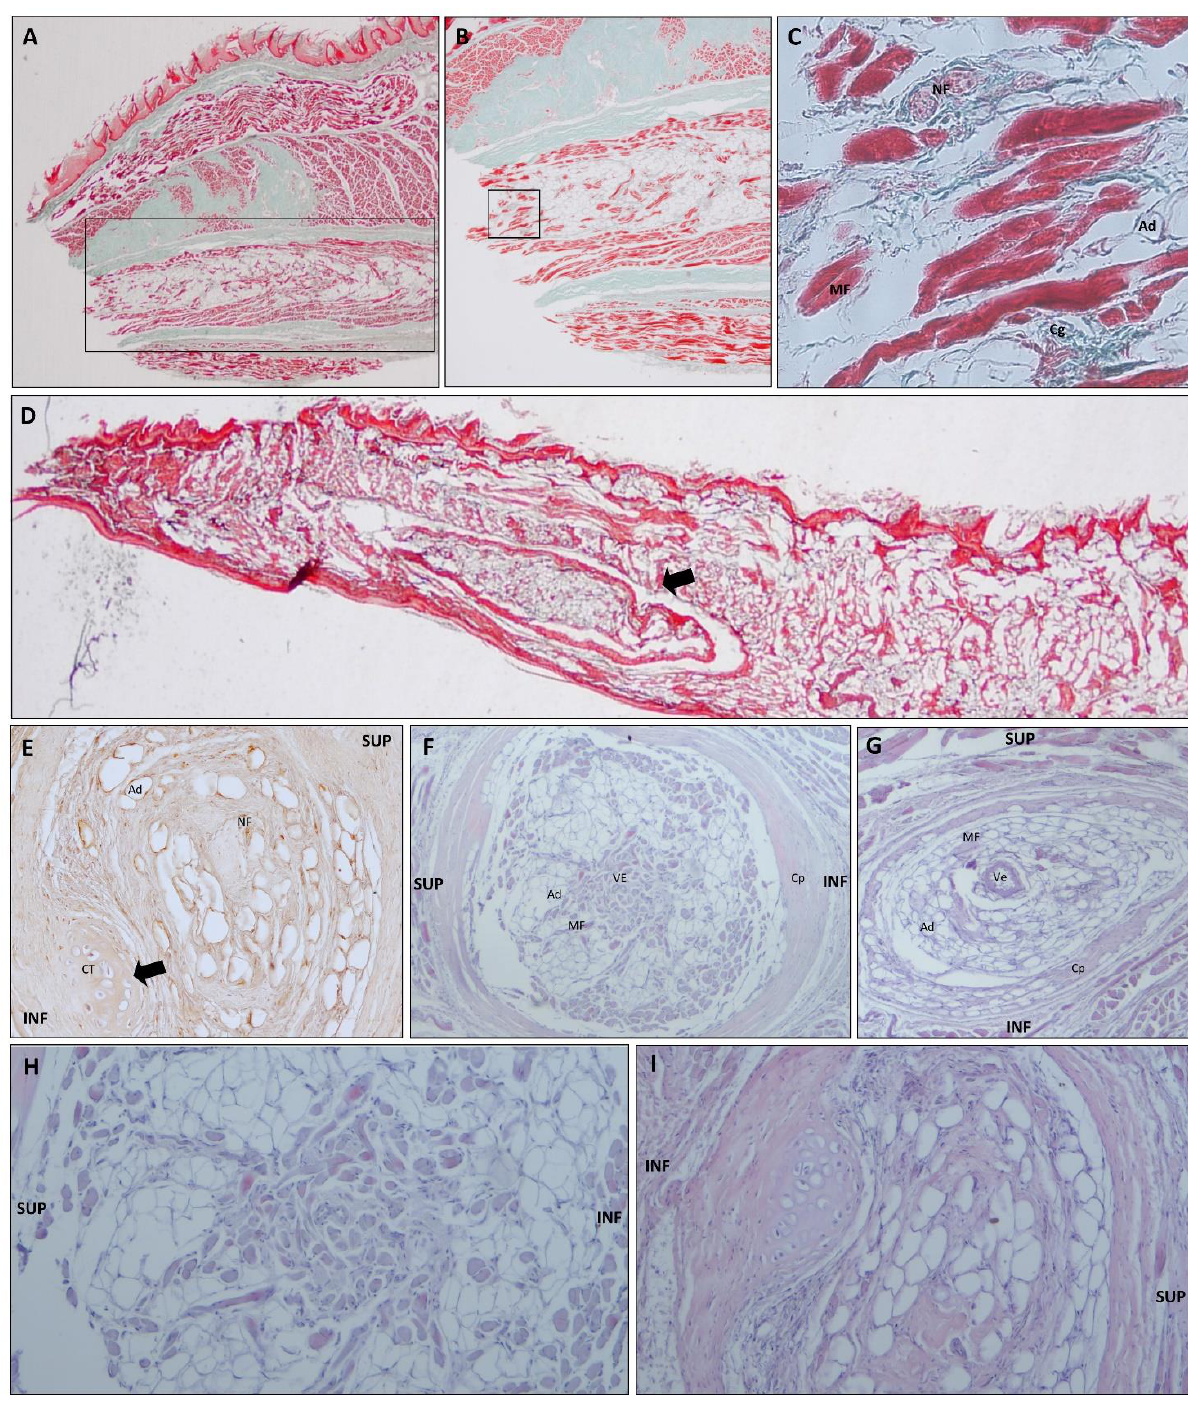
Figure 5. Images that illustrate the encapsulated structure present in the antero-ventral part of the tongue. Images ( A – C , E , I ) correspond to Lemur catta . Images ( D , F , H ) correspond to Varecia variegata . Image ( G ) correspond to Eulemur macaco . Images ( A – D ) (Masson trichrome stain) are from sagital-oriented longitudinal sections. Images ( E ) (S100 immunostain) and ( F – I ) (hematoxylin—eosin stain) are from frontal-oriented transversal sections. Some images, for descriptive purposes, have the following abbreviations: INF (inferior); SUP (superior); NF (nerve fiber); Ad (adipocyte); Cg (collagen); MF (muscle fiber); Ve (vascular element); CT (cartilaginous tissue) and Cp (capsule). In image ( A ) part of the encapsulated structure is remarked. Image ( C ) shows details of the tissue boxed in image ( B ). Image ( D ) shows a panoramic of the position of the encapsulated structure (arrow). Images captured with the following objectives: A , 10×; B , 20×; C , 40×; D , 4×; E – G , 10×; H , I , 20×.